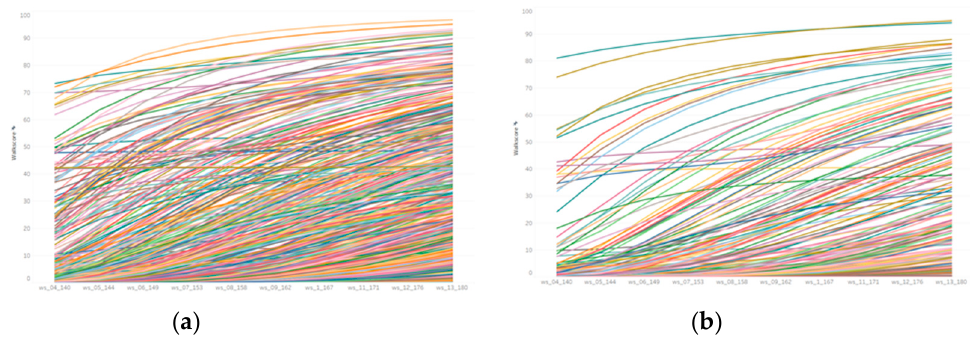
Figure 14. Evolution of WS for the elderly with gait speed and 𝛽 modifications (Ostrava ( a ) and 668 Hradec Kralove ( b )). Hradec Kralove ( b